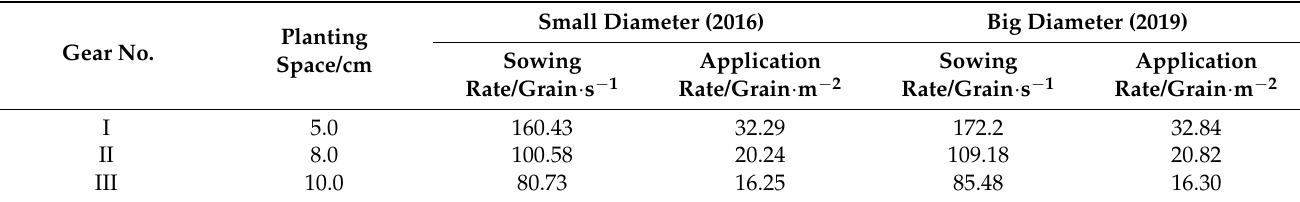
Table 3. Dynamic experimental results of the digital monitoring system.